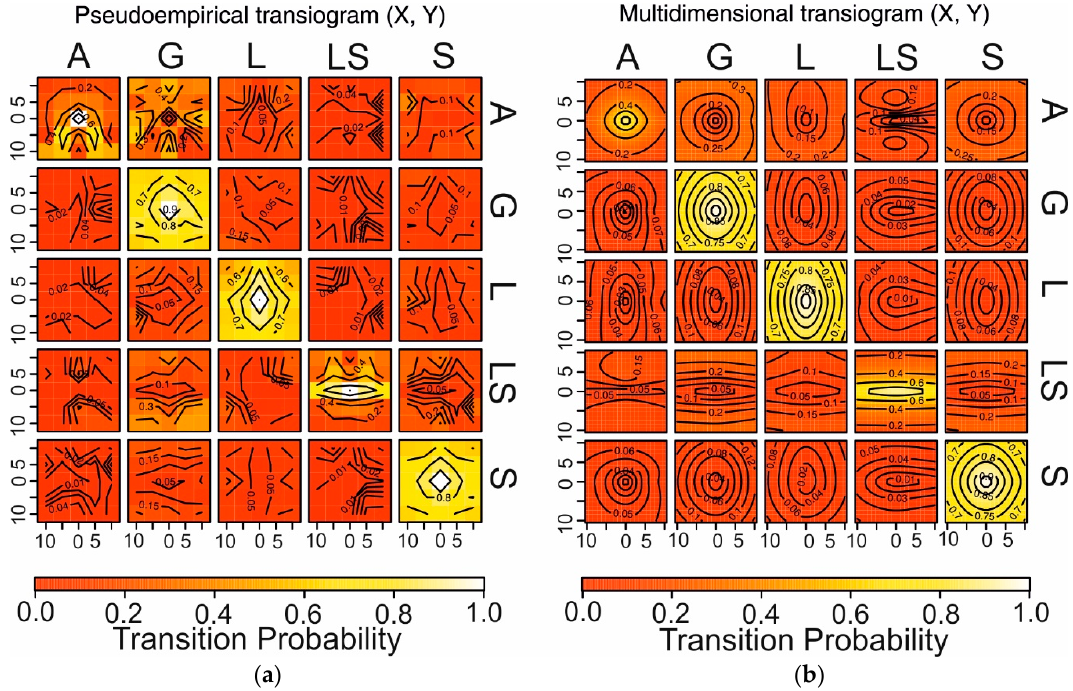
Figure 5. Surface theoretical transiograms without ( a ) and with ( b ) ellipsoidal